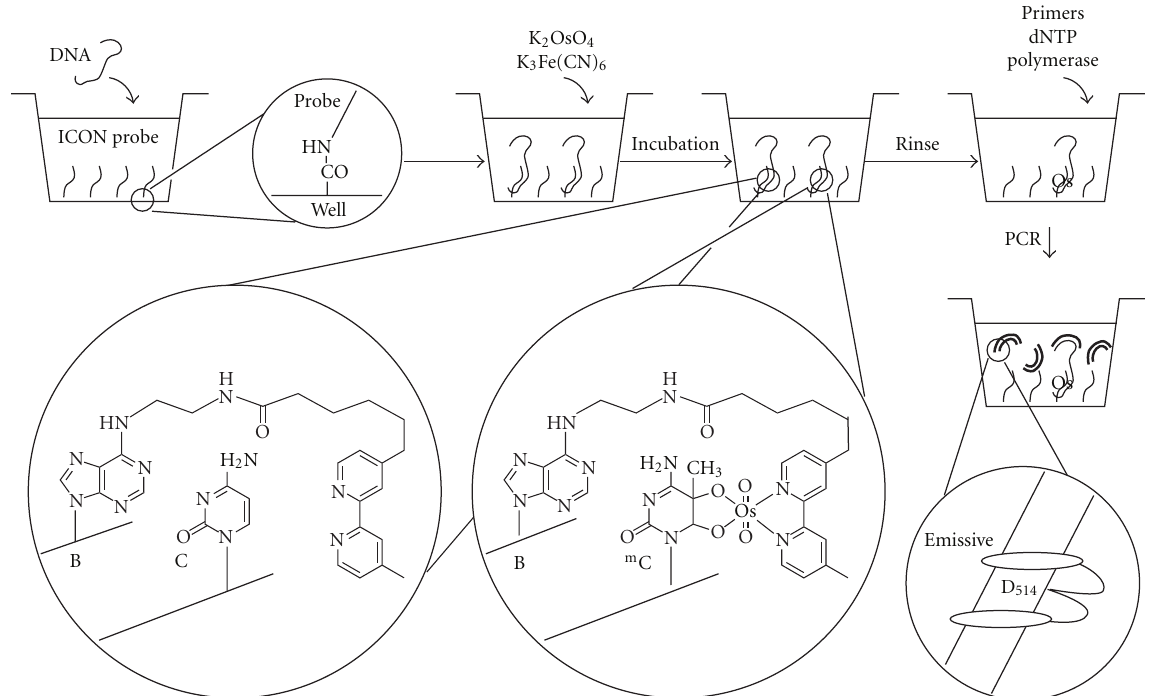
Figure 2: Schematic illustration of on-chip analysis of methylated DNA.